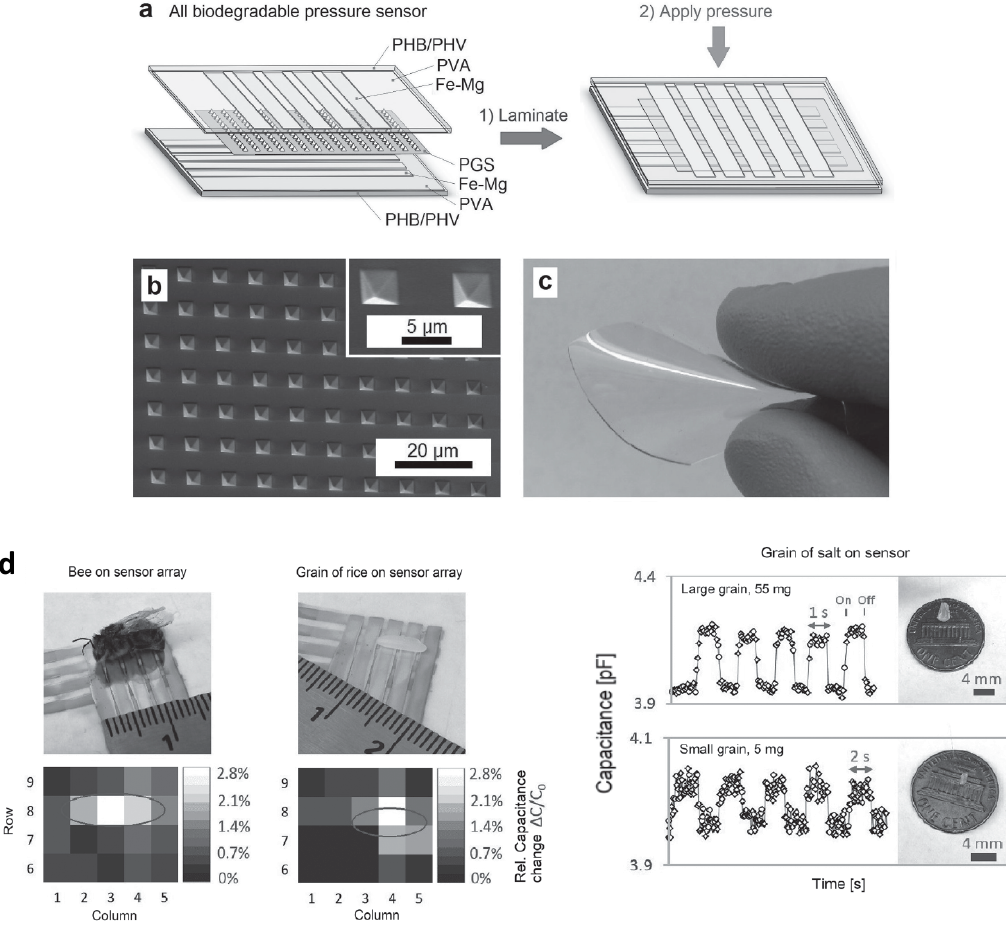
Figure 35. ( a ) Fabrication procedure of the fully biodegradable and flexible pressure sensor array from microstructured poly(glycerol sebacate) (PGS), polyhydroxybutyrate / polyhydroxyvalerate (PHB / PHV) and Fe / Mg as conductors. ( b ) SEM images of the microstructured PGS films (PGS was formed into a PDMS mold). ( c ) Flexible PGS film. ( d ) ( left ) Picture of the sensor array of 4 × 5 pressure-sensitive elements and capacitance change distribution on the sensor array upon placing light weights such as a bee (22.5 mg), and a grain of rice (21.8 mg). ( Right ) capacitance changes as a function of the weight of the object. Adapted from [156] with permission. Copyright © 2015 Wiley and Sons.